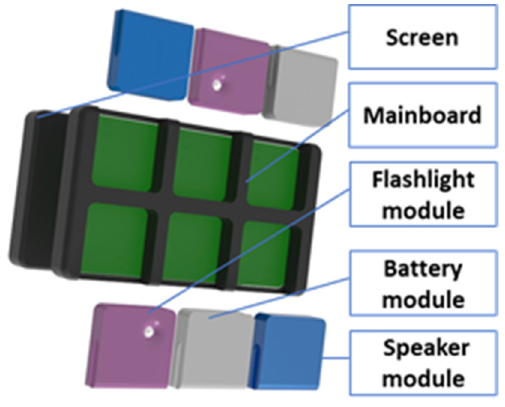
Figure 4. Example of a configuration for the modular, customizable product.